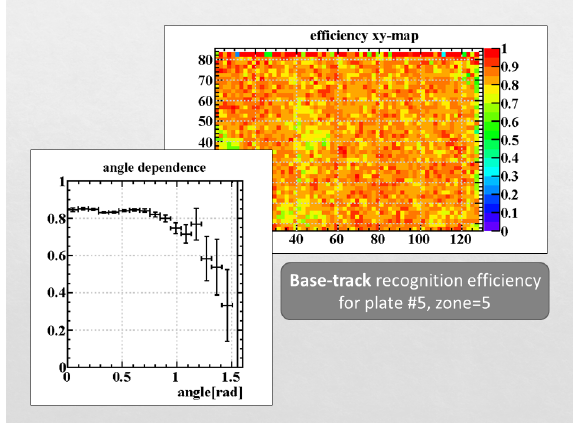
0.85 for tan θ 1.0. It should be noted ∼ ≤